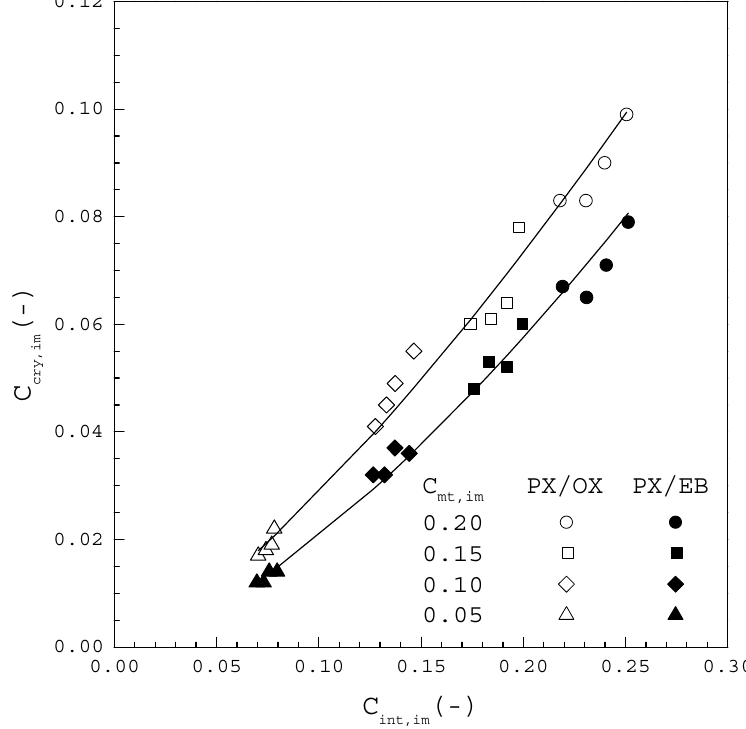
Figure 9. C cry,im plotted against C int,im at the crystal-melt interface for the PX / OX and PX / EB Figure 9. C (cid:2913)(cid:2928)(cid:2935),(cid:2919)(cid:2923) plotted against C (cid:2919)(cid:2924)(cid:2930),(cid:2919)(cid:2923) at the crystal-melt interface for the PX/OX and PX/EB mixtures. Figure 9. C (cid:2913)(cid:2928)(cid:2935),(cid:2919)(cid:2923) plotted against C (cid:2919)(cid:2924)(cid:2930),(cid:2919)(cid:2923) at the crystal-melt interface for the PX/OX and PX/EB mixtures.